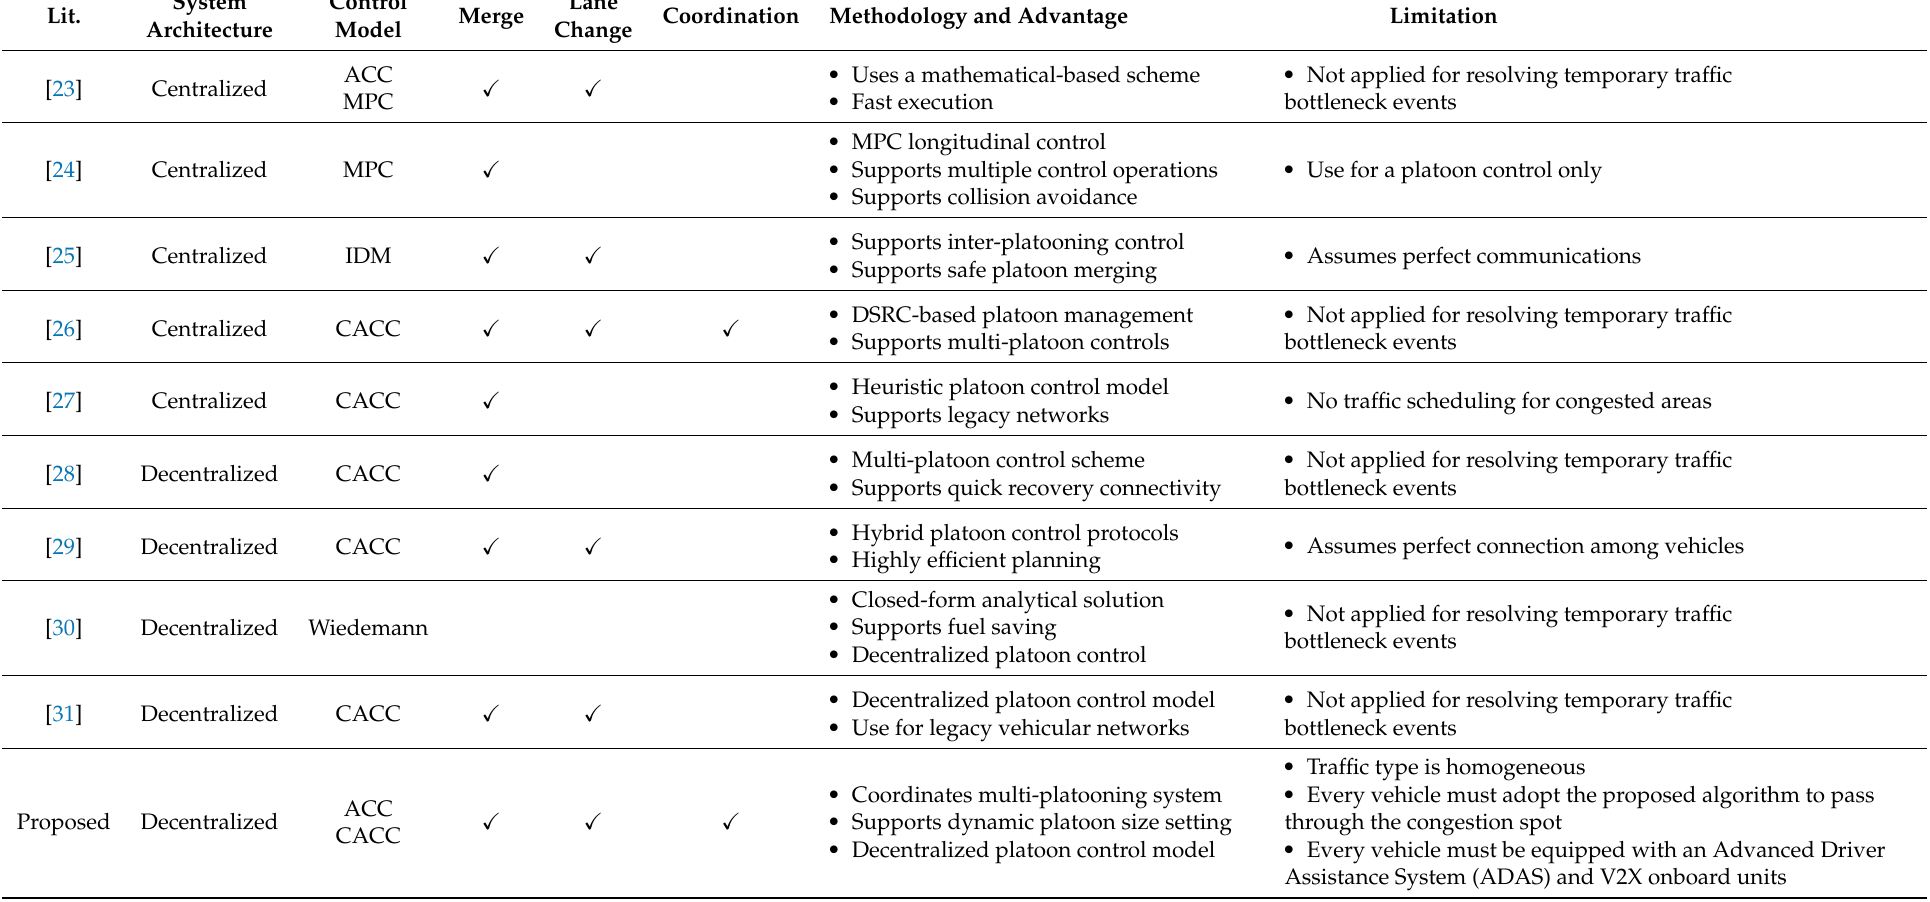
Table 2. Comparison of related